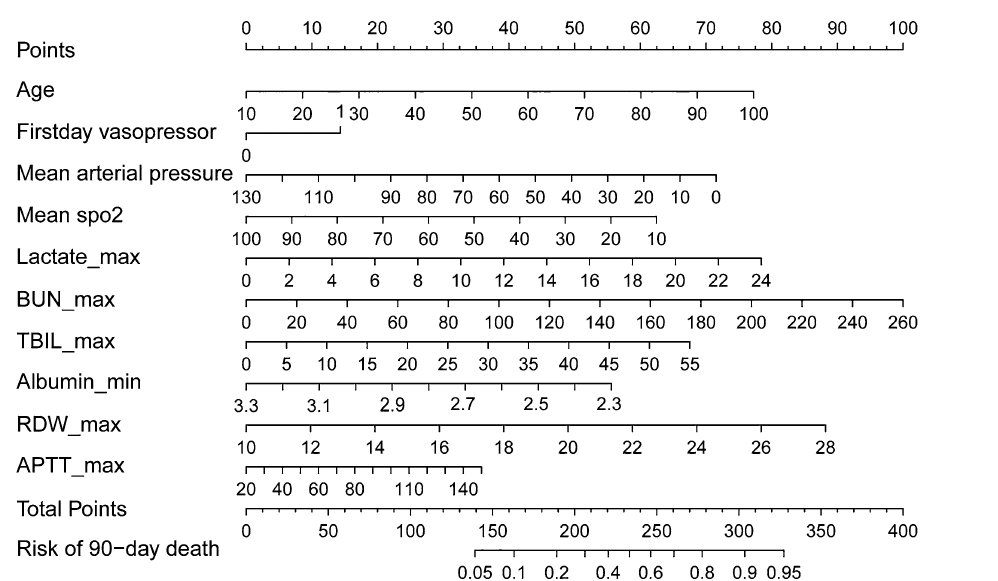
Figure 2. Factors independently associated with 90-day mortality in SALI patients in the training cohort by multivariate logistic regression analysis with forest plots.